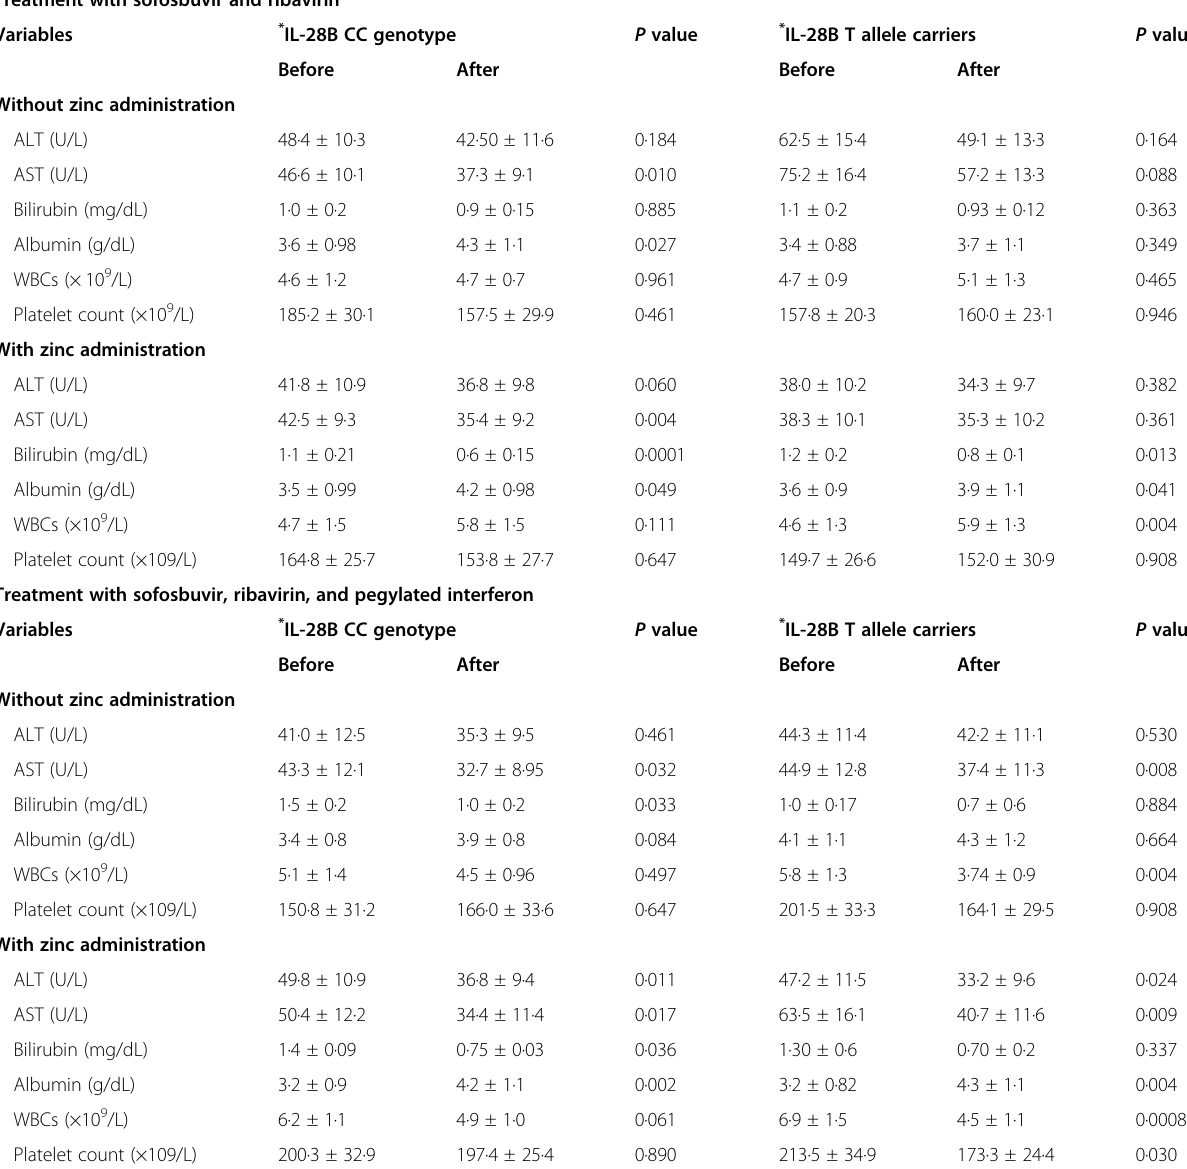
Table 1 Patient ’ s characteristics before and after antiviral treatments Treatment with sofosbuvir and ribavirin